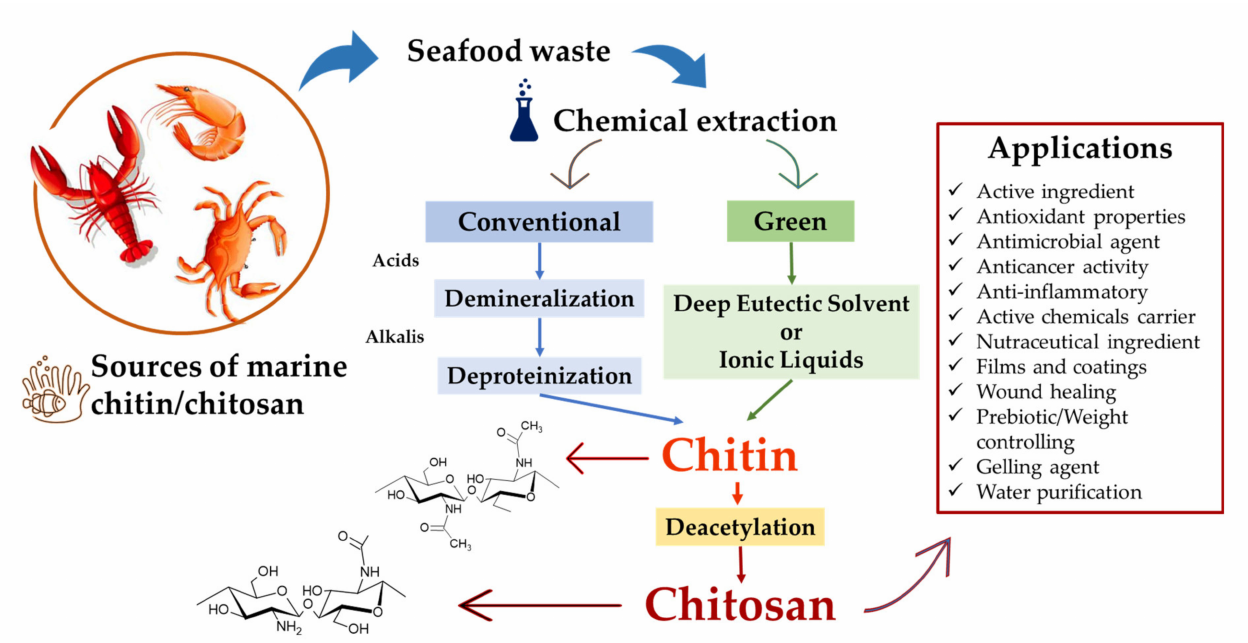
Figure 3. Summary of chitin/chitosan extractions and